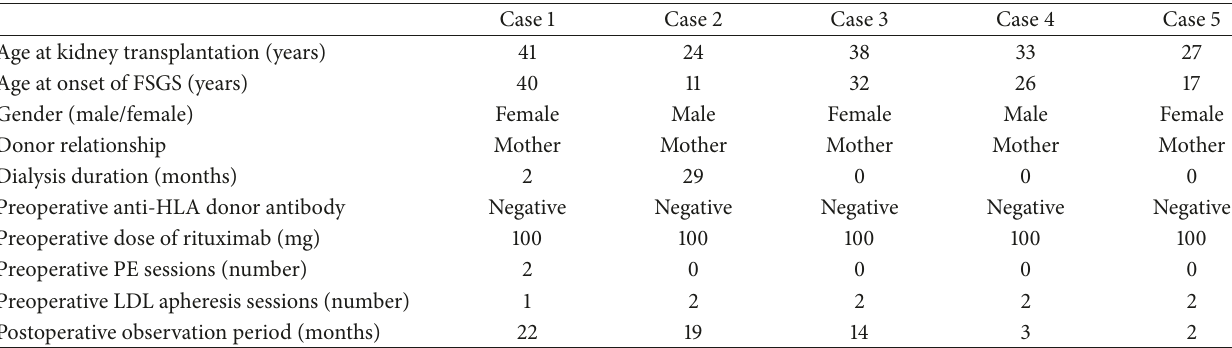
Table 1: Clinical characteristics of the patients.